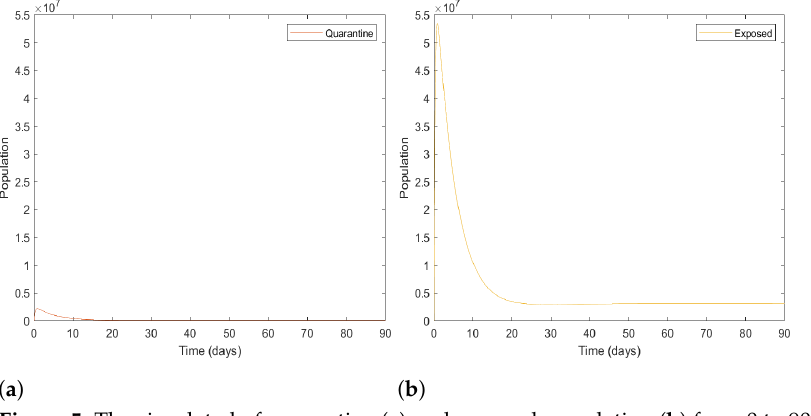
Figure 5. The simulated of quarantine ( a ) and exposed population ( b ) from 0 to 90 days. The dynamics of the hospitalized infected and infected population are related to the dynamics of the quarantine and exposed population, respectively. As a result of the incubation period population changes to the infected population, the dynamics of hospitalized infected population and infected population increase rapidly over 0–7 days, with the peak population estimated at 7,500,000 and 22,700,000, respectively. After that, it declines rapidly. The dynamics of the hospitalized infected and infected population are shown in Figure 6a,b